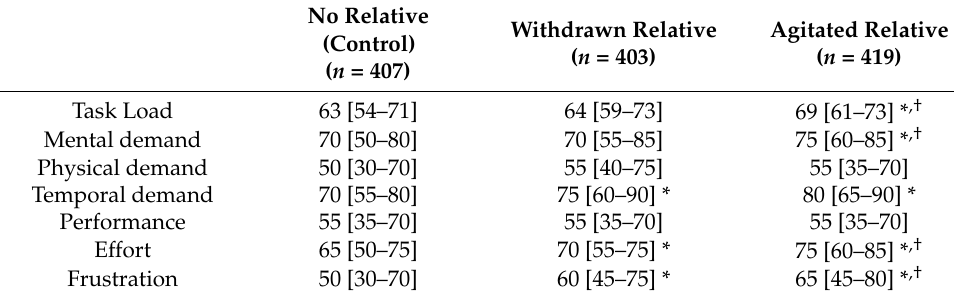
Table 2. NASA Task load findings– single components.